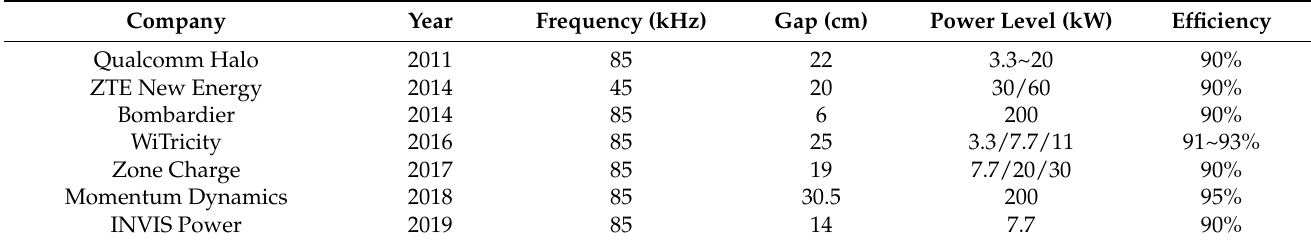
Table 4. Results and parameter indicators of companies on WPT